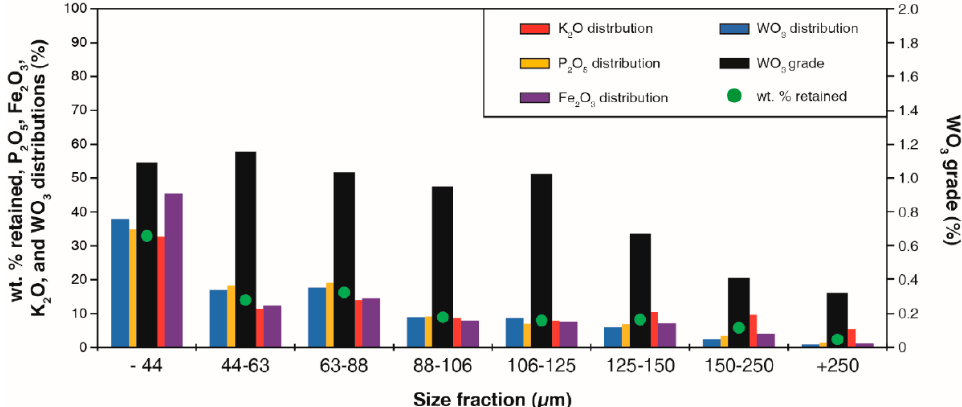
Figure 1. WO3 grade, wt % retained and main oxides size-distributions in feed material used for the Falcon tests.